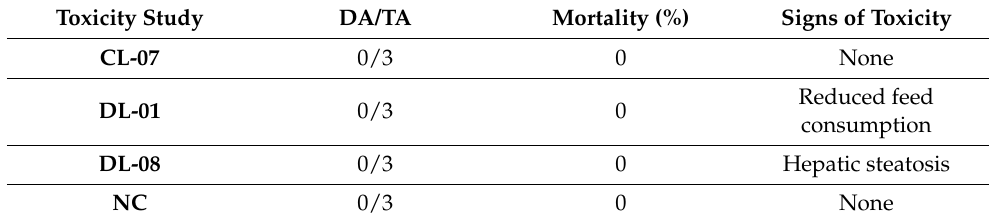
Table 6. Effects of acridines derivatives in animals submitted to acute toxicity